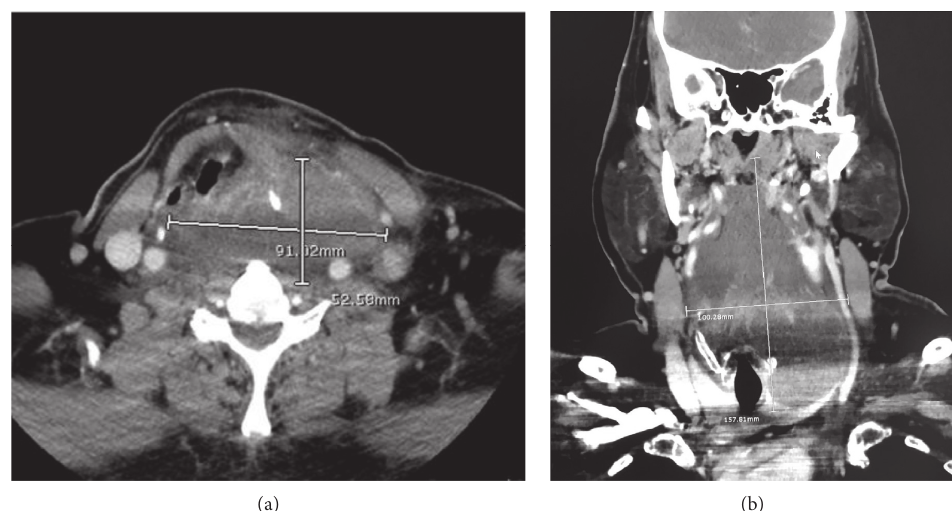
Figure 1: Computed tomography scan of the neck. (a) Axial and (b) coronal views showing a large lobulated partial rim-enhancing hypodense lesion with internal septation in the deep space of the left